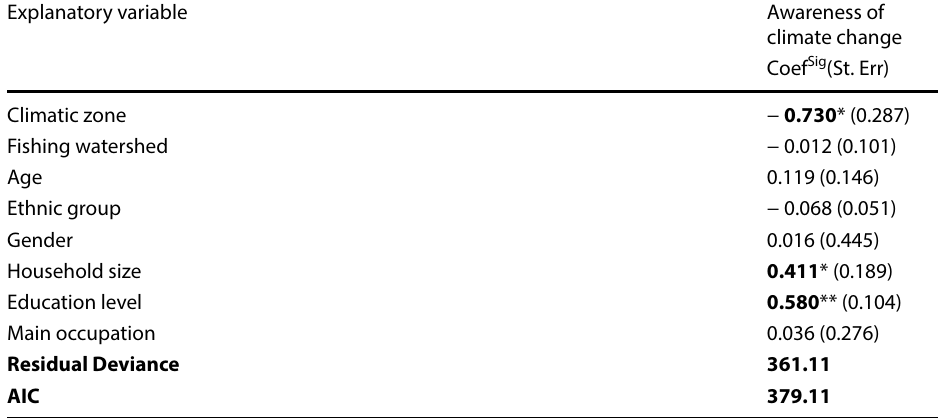
Table 6 Results of multinomial logistic regression of socio- demographic factors determining Ivorian fishermen’s awareness of